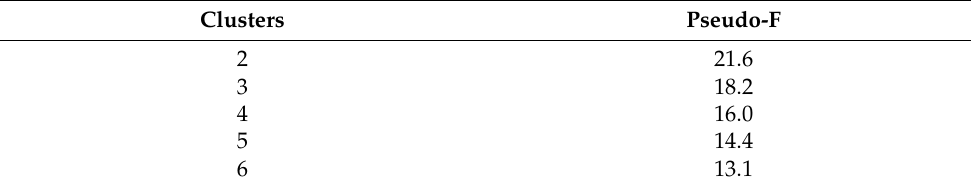
Table 1. Cluster homogeneity.